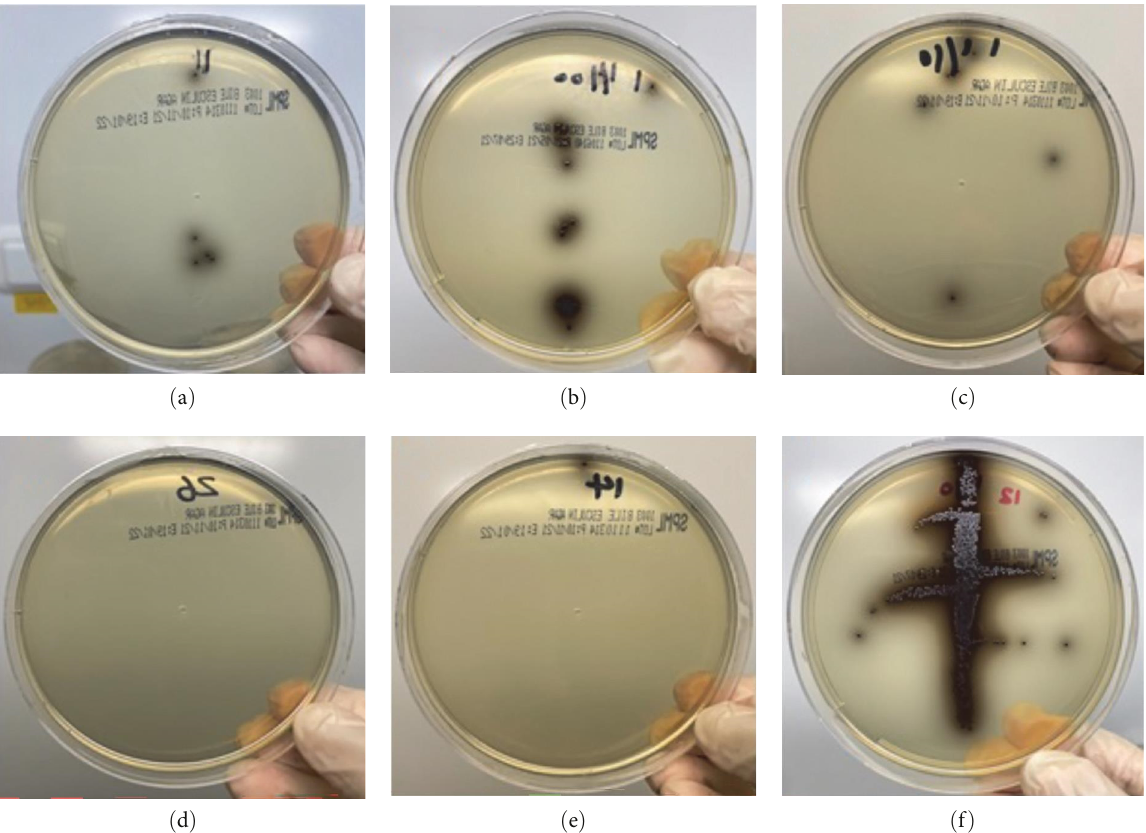
F IGURE 7: Growing colonies of E. faecalis on bile esculin agar plates after application of the tested irrigants (CFU-2): (a) few growing colonies after using 2.5 % NaOCl; (b) few growing colonies after using 0.1 % OCT; (c) few growing colonies after using M. oleifera extract; (d) no growing colonies after using M. oleifera extract +1.25 % NaOCl; (e) only one growing colony after using M. oleifera + 0.1 % OCT; (f) high numbers of growing colonies of E. faecalis after using saline.